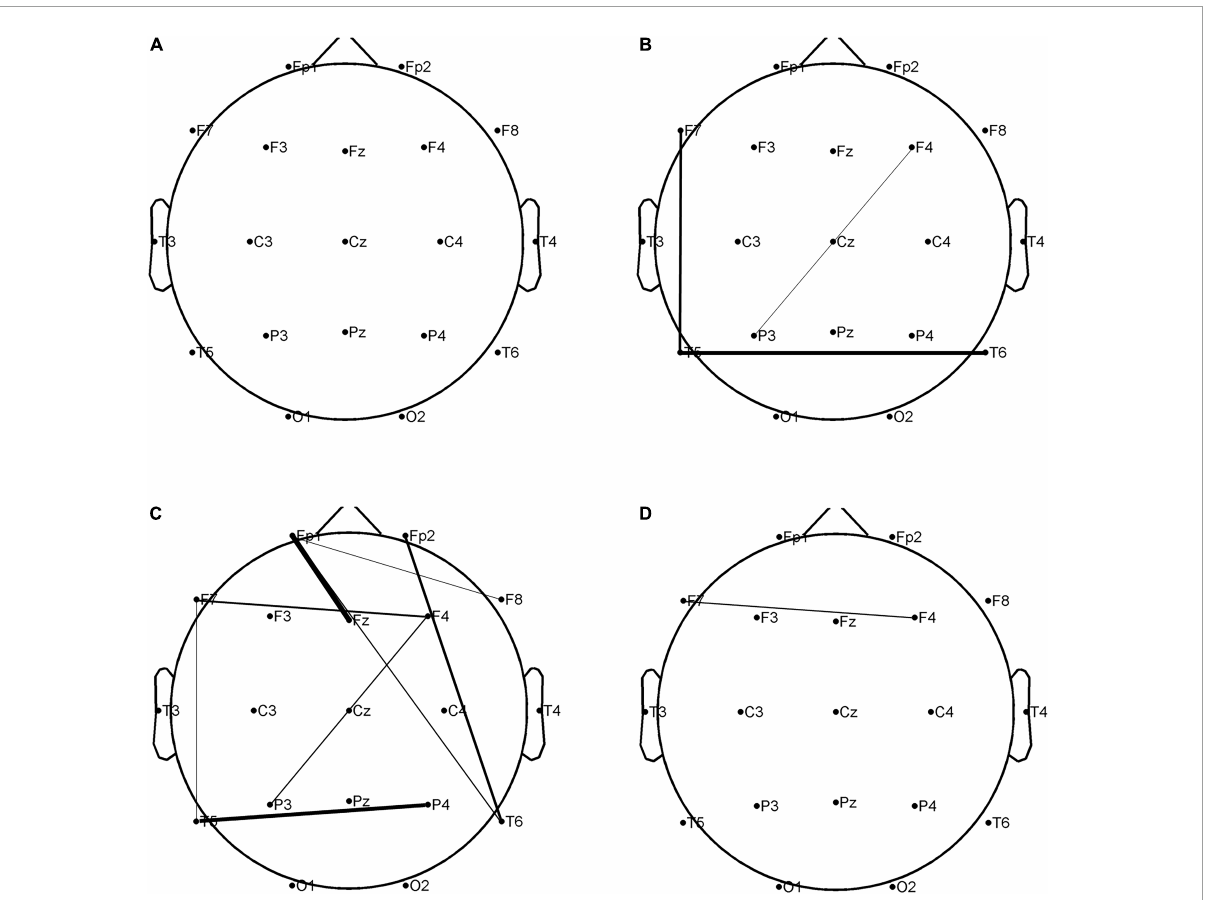
FIGURE5 In the combined clinical-PLV EEG model, there were statistically significant differences in 12 PLV EEG features between the CON and CI groups of PWEs. The higher the fisher score, the tighter the connection between the leads. P < 0.05 is considered statistically significant. (A) Alpha band; (B) beta band; (C) theta band; (D) delta band. PWEs, patients with epilepsy; PLV, phase locking value; CI, cognitive impairment; CON, cognitively normal.